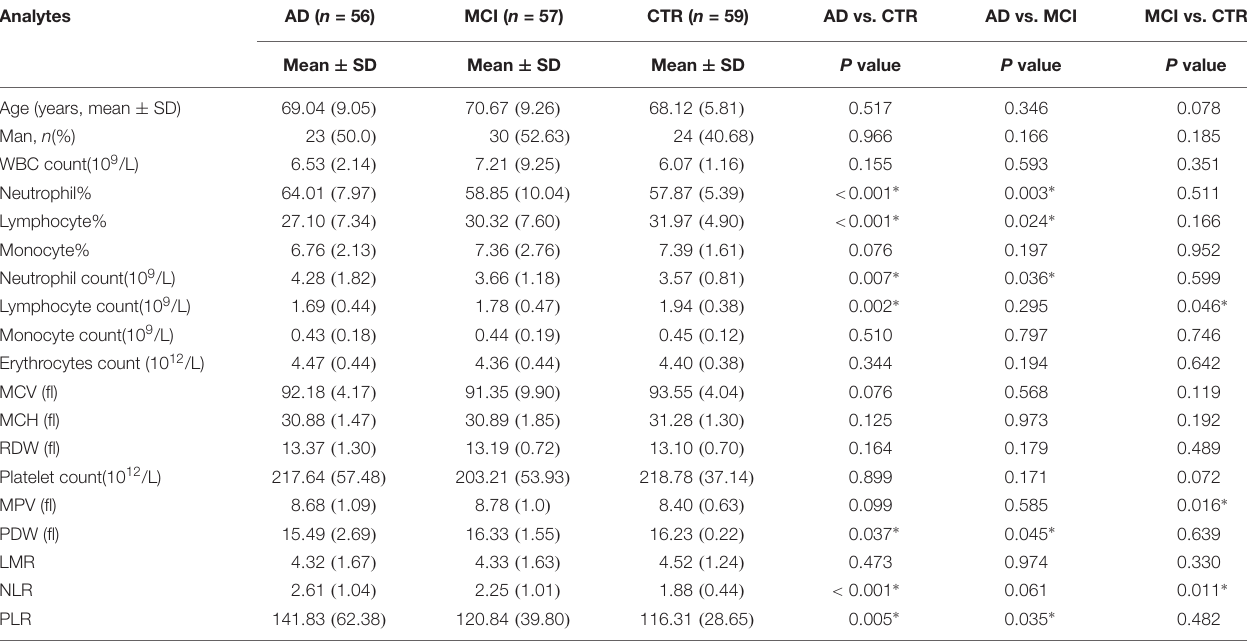
TABLE 1 | Blood routine analytes associated with clinical state in the discovery phase.